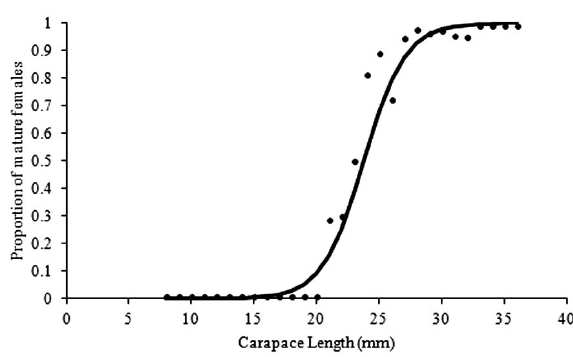
F ig . 10. – Maturity ogive for females of Squilla mantis